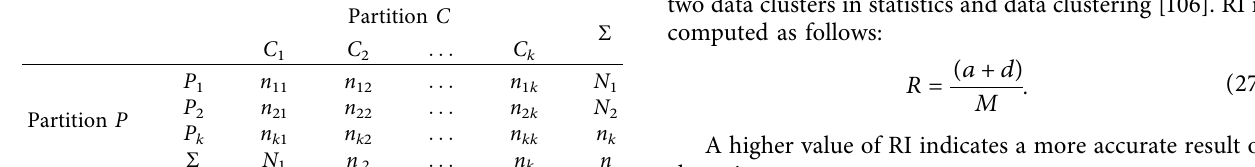
Table 1: Contingency table. Partition